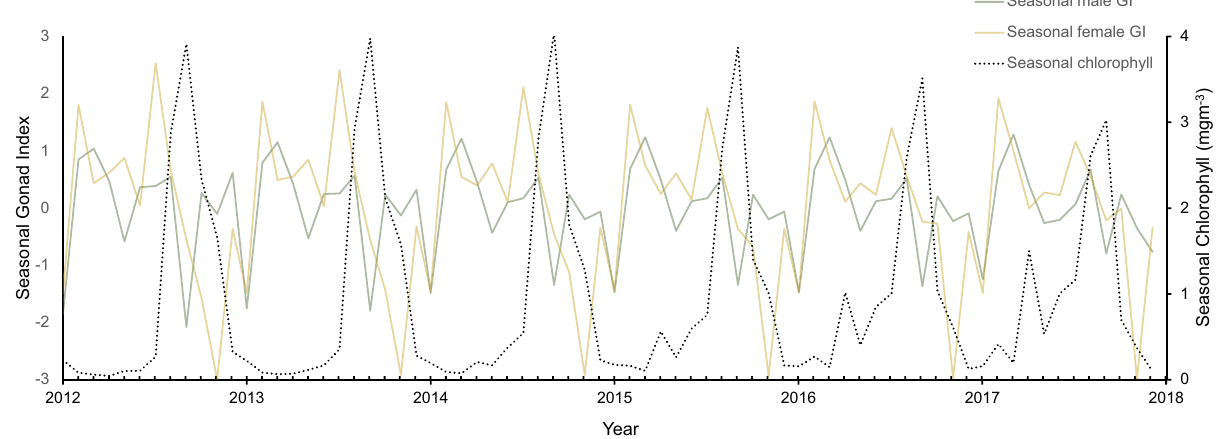
Figure 5. Seasonal cycle of gonad index for males (solid green line) and females (solid yellow line), extracted from decomposition analysis, overlaid on seasonal cycle of chlorophyll (dotted black line) extracted from decomposition